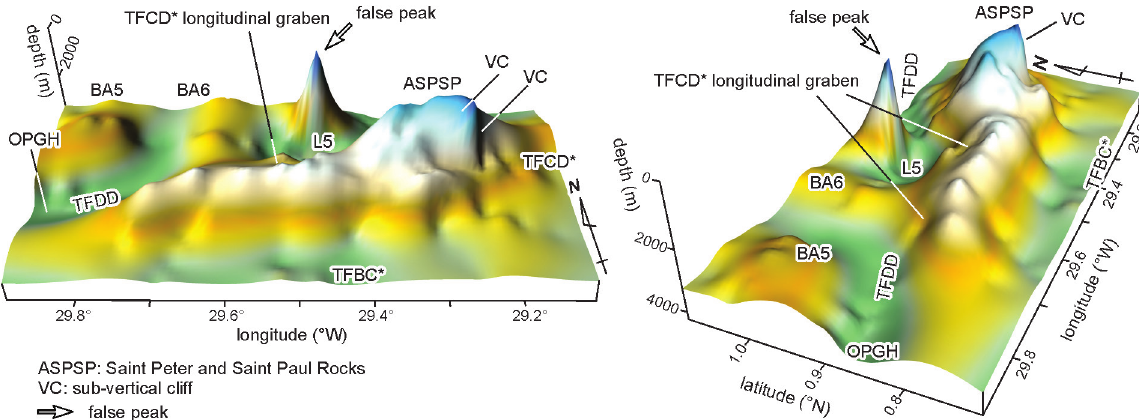
Figure 13 - Detailed submarine morphology for the area of the Saint Peter and Saint Paul peridotite ridge, based on Global Topography ver. 14.1. The abbreviations are the same as in Figure 1. The TFDD is the plate boundary proposed by Sichel et al. (2011) and the TFCD*, the longitudinal graben recognised by Hekinian et al. (2000).